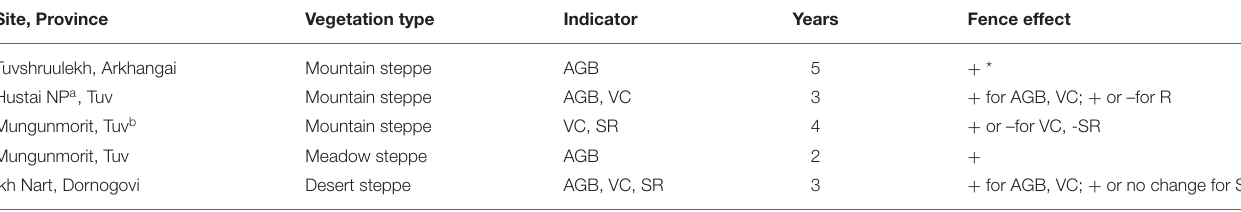
TABLE 4 | Summary of the effects of fence/grazing intensity and year on AGB, VC, and SR in different vegetation types. Site, Province